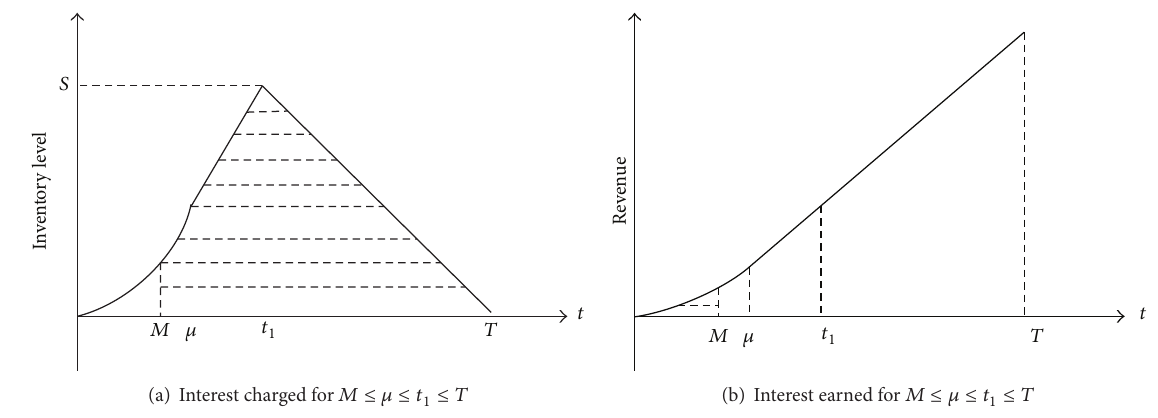
Figure 5: Interest charged and interest earned for 𝑀 ≤ 𝜇 ≤ 𝑡 1 ≤ 𝑇